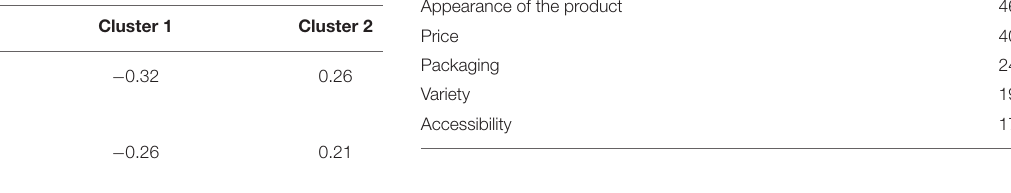
TABLE 7 | Food neophobia and willingness to consume insect-based products in the future.